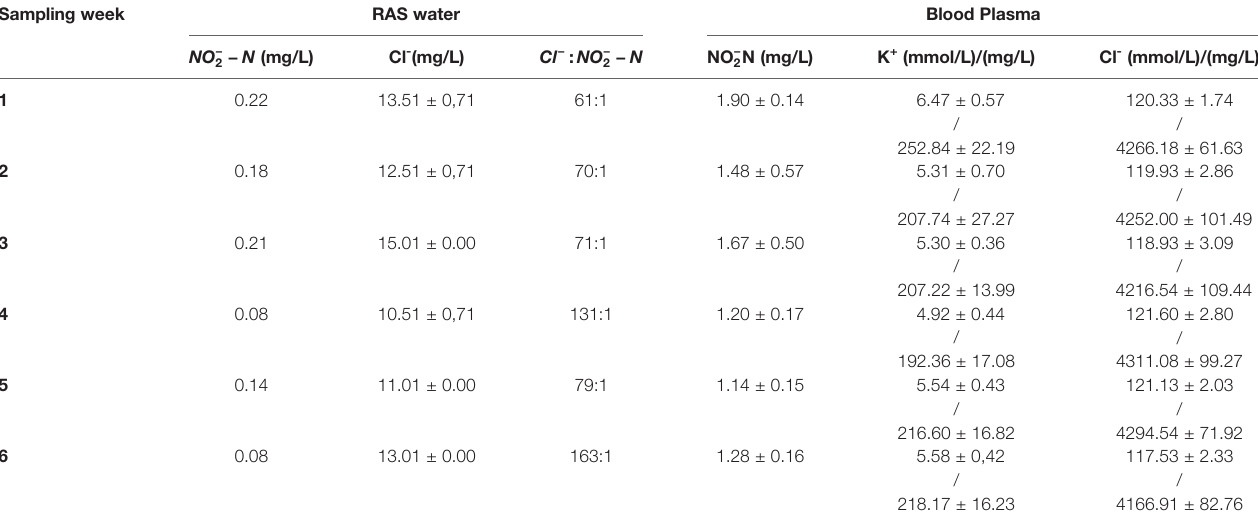
TABLE 1 | To the left the NO − 2 − N and the mean Cl - (± SD, N = 2) concentration in the RAS water, and the Cl − : NO − 2 − N ratio on each sampling day. To the right the mean (± SD, N = 15) blood plasma concentration of NO − 2 − N , K + and Cl - .